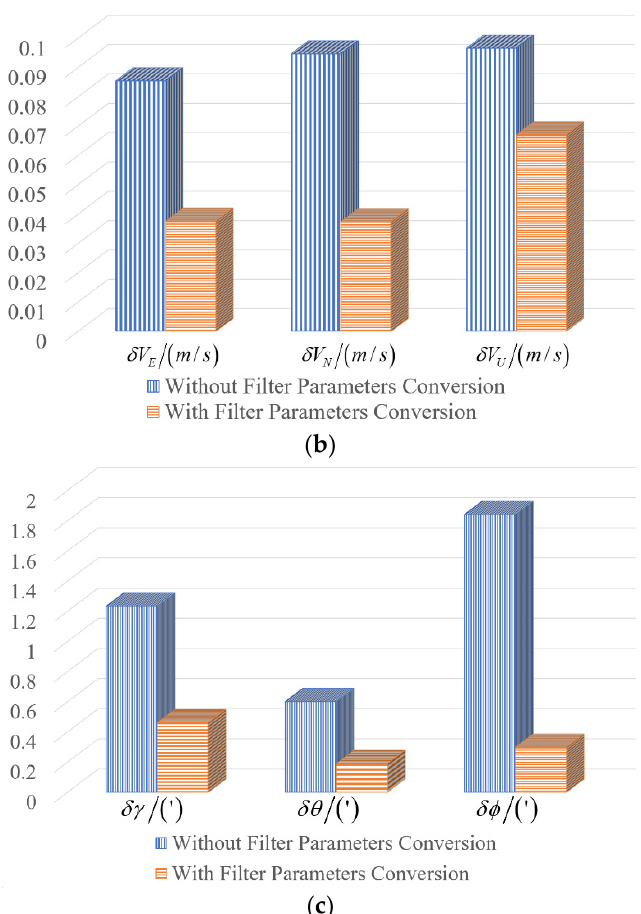
Figure 5. The RMSEs of multi-information fusion autonomous navigation: ( a ) the RMSEs of the position; ( b ) the RMSEs of the velocity; and ( c ) the RMSEs of the attitude.